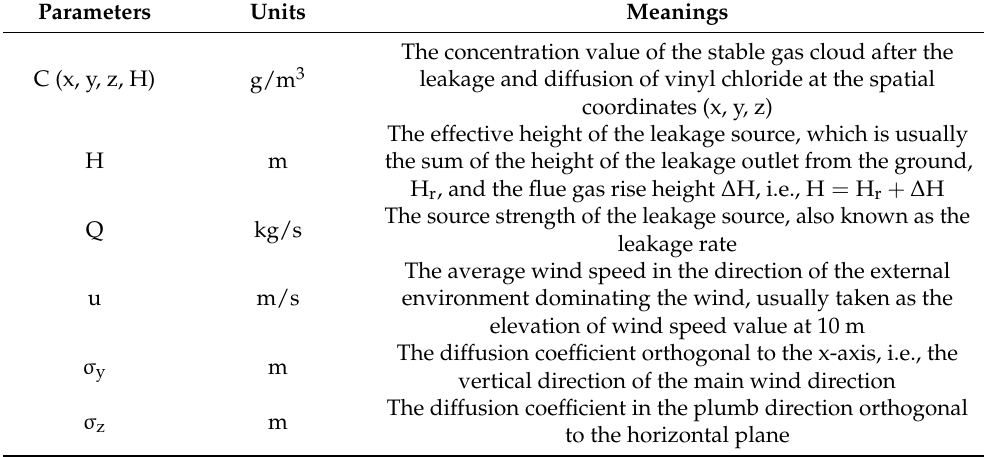
Table 1. Gaussian diffusion formula parameters.